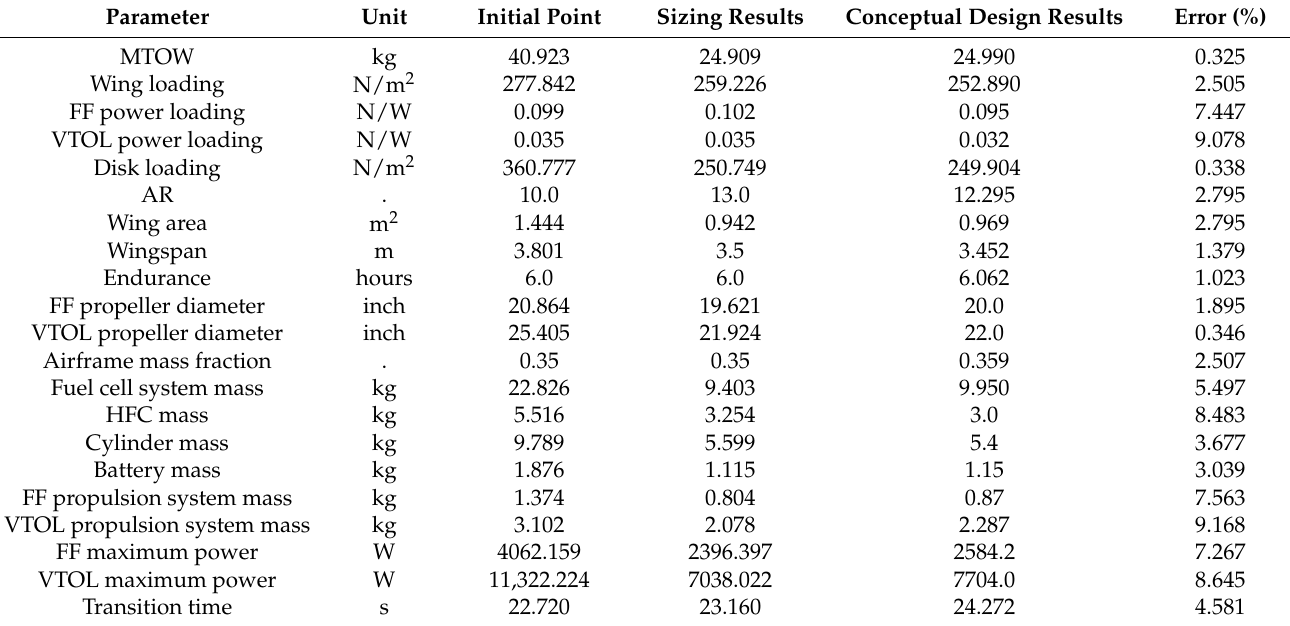
Table 9. Comparison of initial point, sizing results, and conceptual design